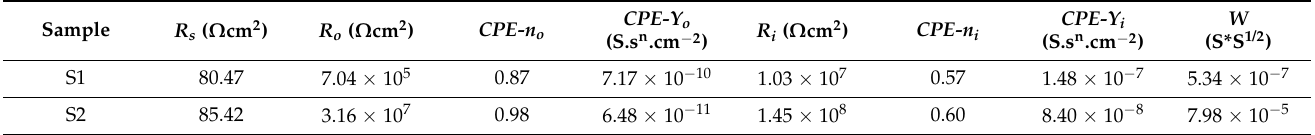
Table 3. Results of the EIS tests of S1 and S2 samples immersed in a 3.5 wt.% NaCl solution.